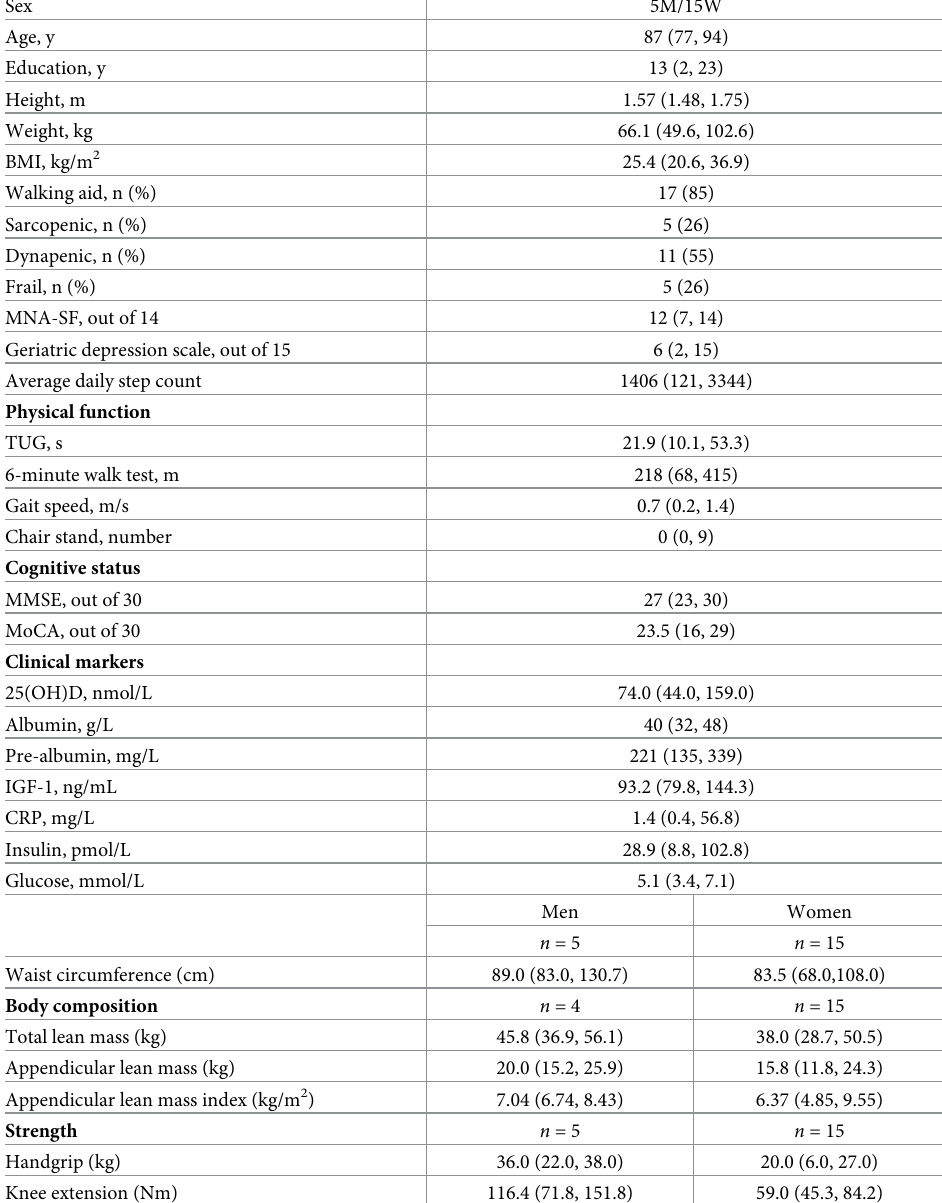
Table 1. Baseline descriptive characteristics of